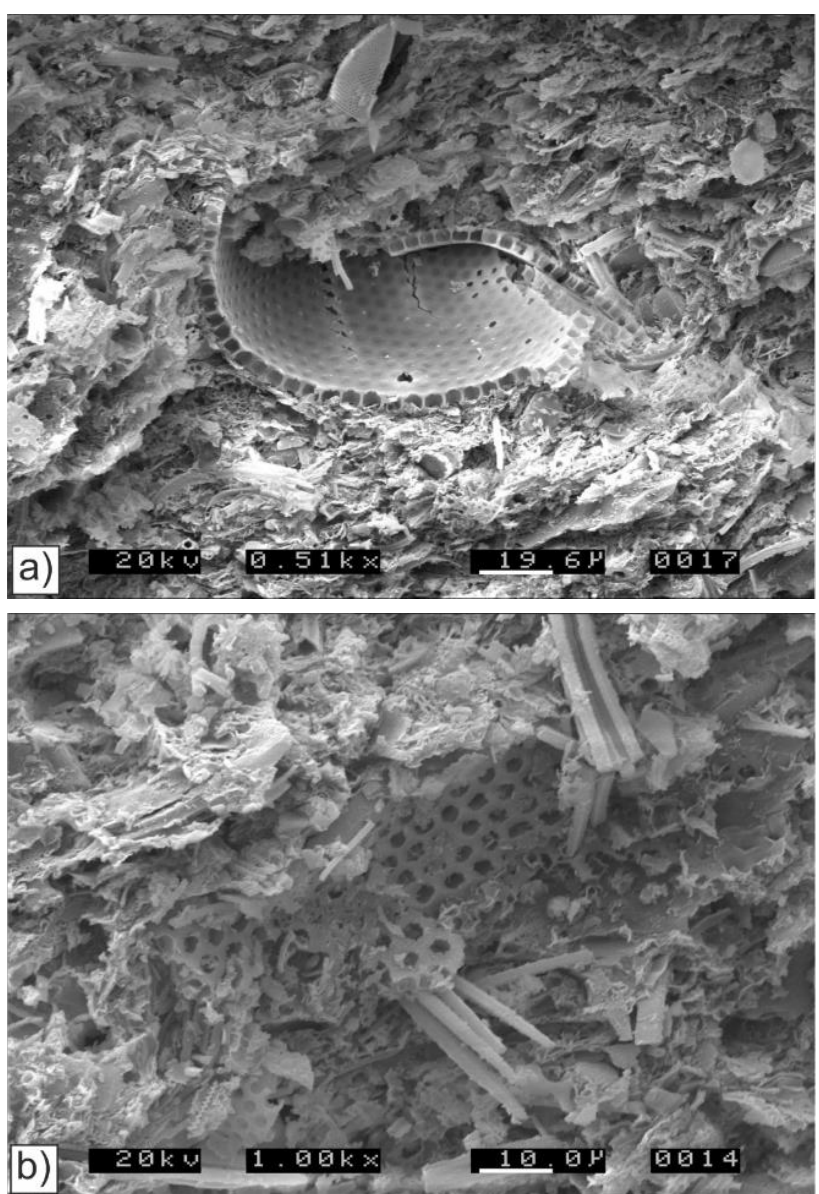
Figure 7. Scanning electron microscopy (SEM) images of the bio siliceous mudstone sample (TH-01) from the Upper Kreyenhagen, Monocline Ridge (TGIC, Figure 3b). The sample is consolidated. ( a ) Crushed parts of a large diatom test in which the pristine opal A micro-texture is preserved. The surrounding bio silicious groundmass is largely comminuted fragments from crushed diatom shells; scale bar = 19.6 µ m. ( b ) Micro-porous test fragments (opal A) in a groundmass of crushed tests; scale bar = 10 µ